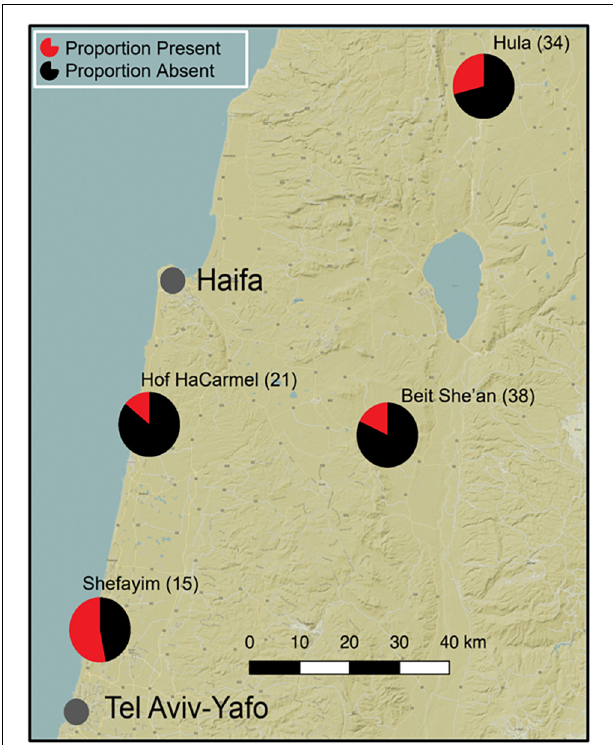
FIGURE 1 | The distribution of Salmonella in barn swallows ( Hirundo rustica ) across four sampling locations in Israel. The proportion of birds with Salmonella (red) and without Salmonella (black), as determined by 16S rRNA gene sequencing (pre-rarefying), is shown for each site, with samples sizes in